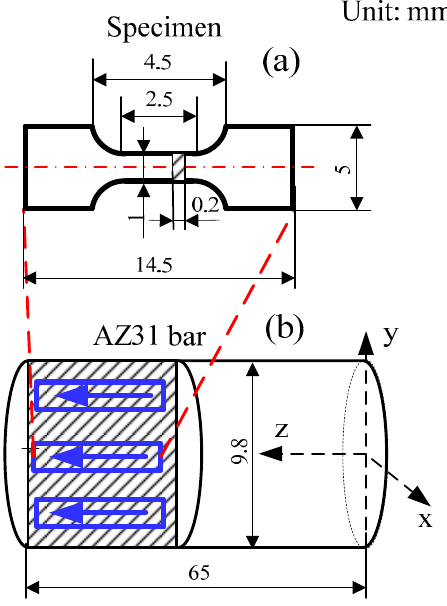
Figure 1. ( a ) Dimensions of the micro-tension specimens, and ( b ) illustration of the dog-bone shape specimen specimen preparation.